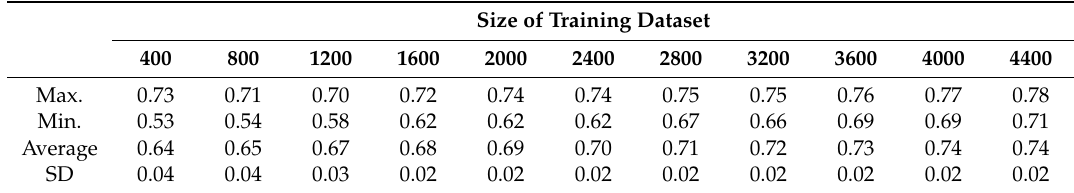
Table 7. Model accuracy with testing 20 building characteristics for spectral-yield displacement S dy .